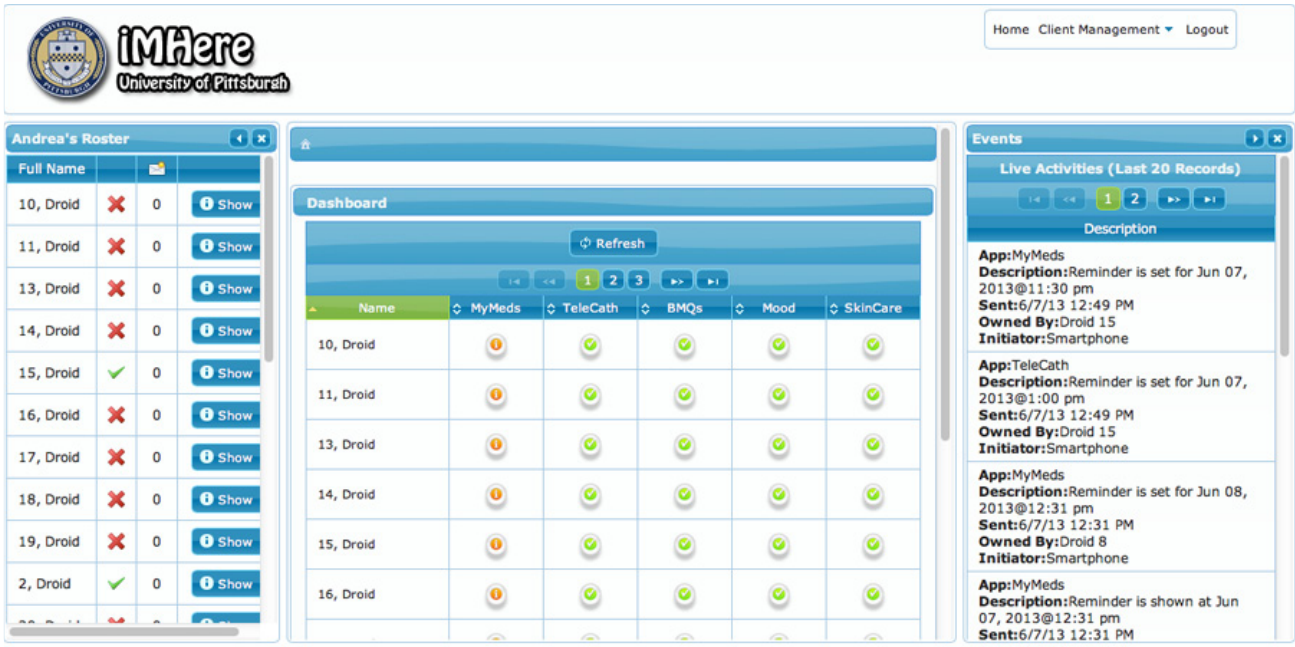
The portal maintains a persistent connection with all registered patients’ devices currently running